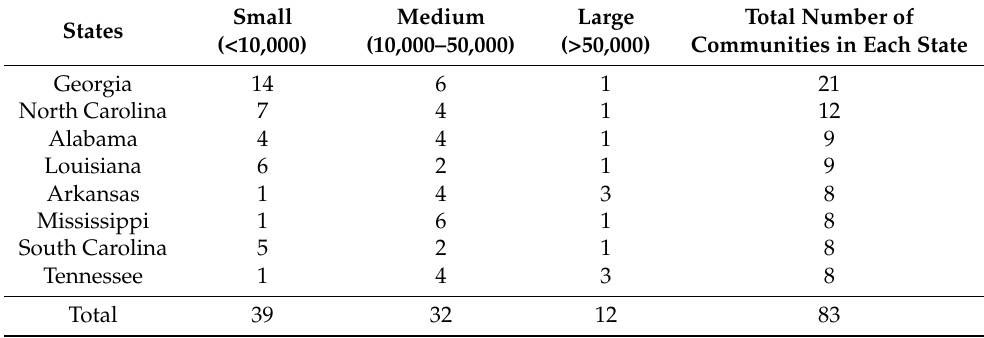
Table 2. Final sample size by state and population